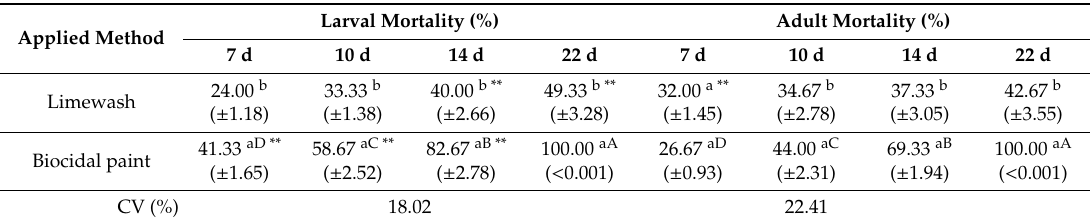
Table 4. Mortality rates of Alphitobius diaperinus and mortality di ff erence between larvae and